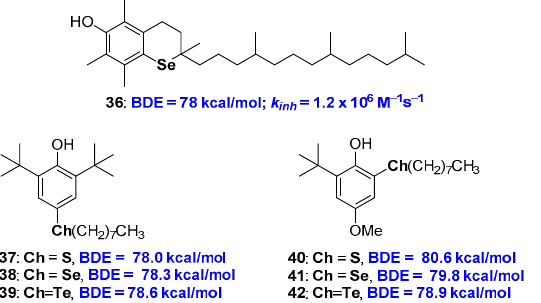
Figure 11. all rac -1-Seleno- α -tocopherol 36, and model chalcogen substituted polyphenols used to quantify the substitution contribution on chain breaking activity.